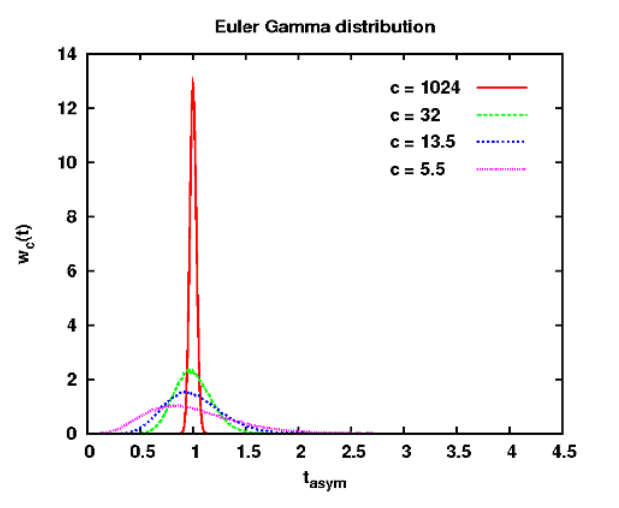
Fig. 1. Gamma distributions for the values of the Tsallis parame- ter c which were used in our numerical